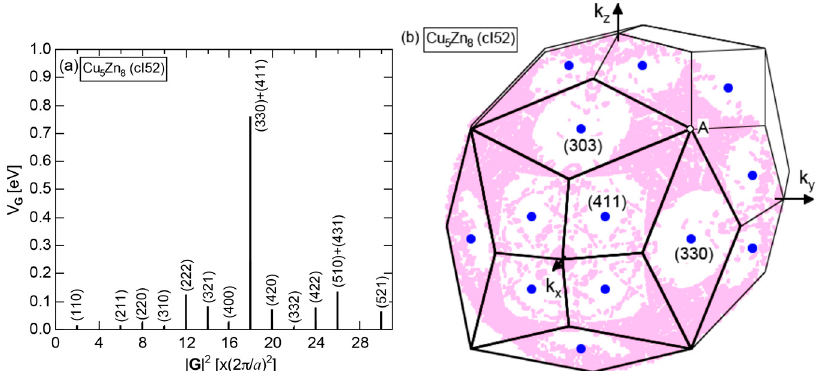
Figure 37. ( a ) The | G | 2 -dependence of the Fourier-transformed empty-core potential or the form factor, V G , calculated in the context of NFE band calculations for Cu 5 Zn 8 (cI52) gamma-brass [19]; ( b ) The Fermi surface in the extended zone scheme for Cu 5 Zn 8 (cI52) gamma-brass. Blue dots represent the center of {330} and {411} zone planes. The highest energy is attained at the point “A” on the Brillouin zone. Star-shape pink areas with their centers underneath the point “A” represent spherical Fermi surface inside the Brillouin zone, while white areas the necks formed around centers of the respective zone planes.